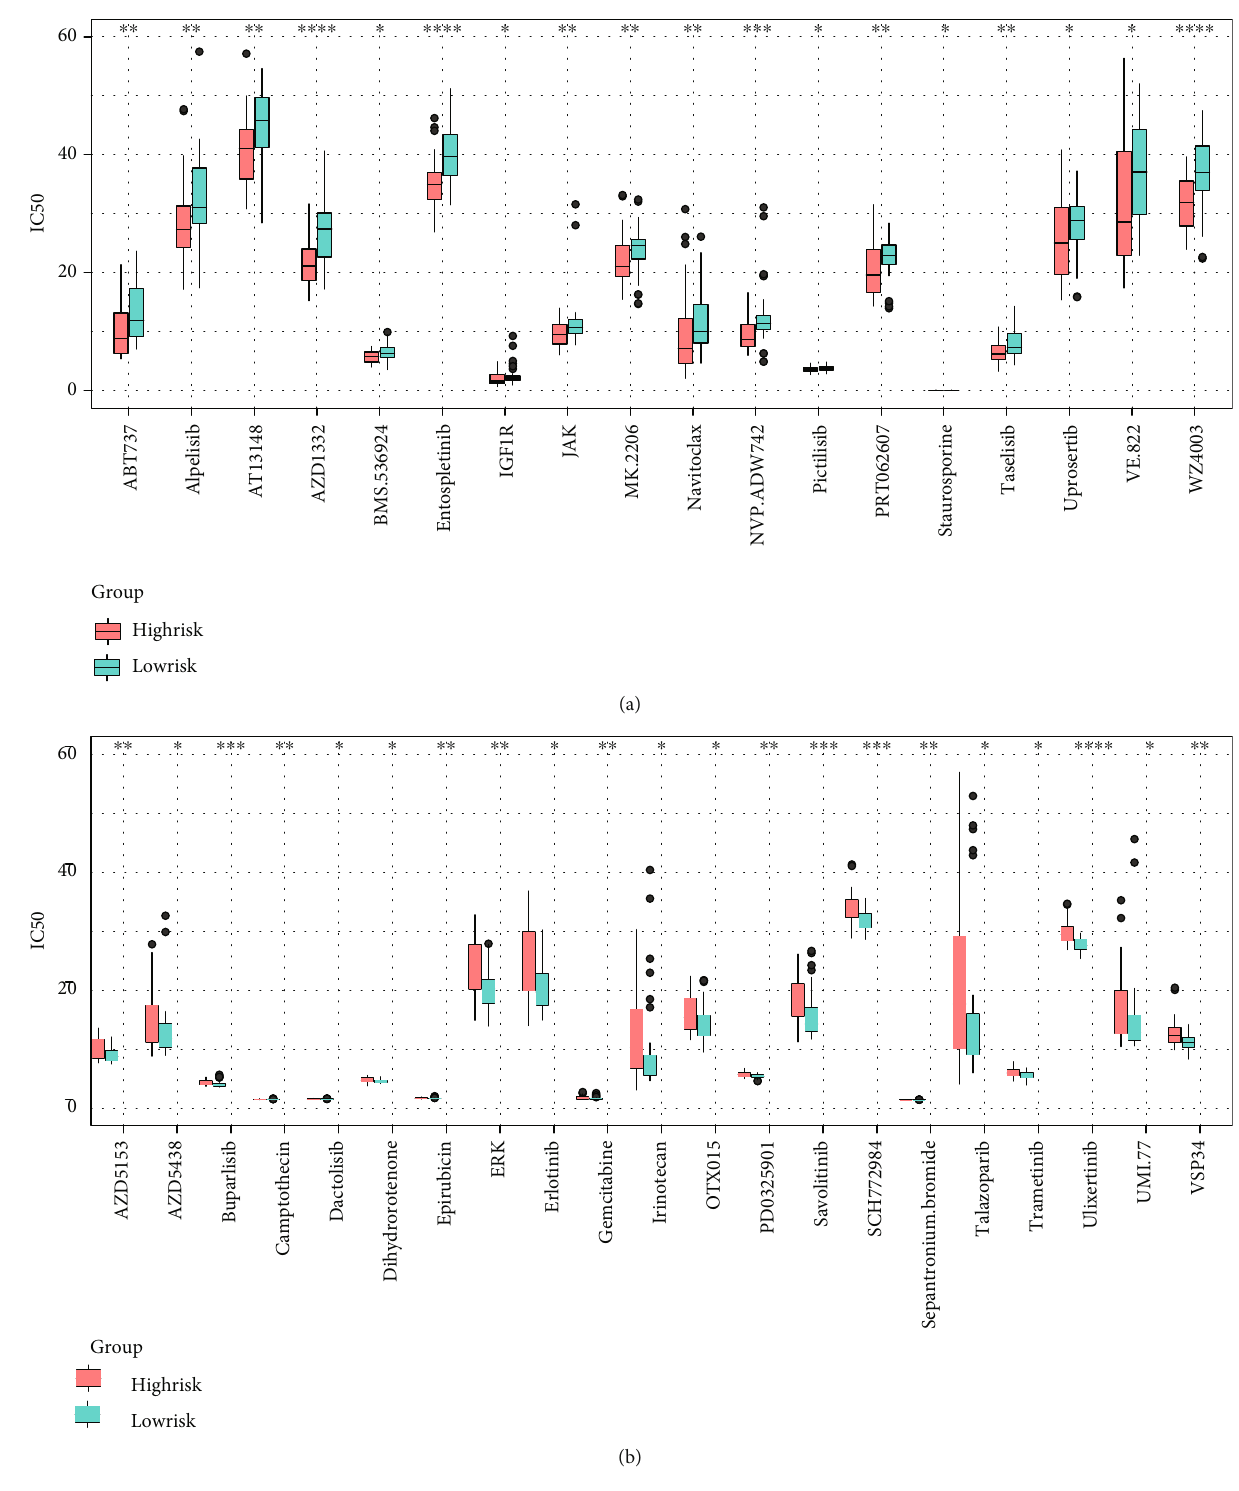
Figure 6: Di ff erences in chemotherapeutic drug sensitivity between high-/low-risk group. (a) Drugs that are more sensitive to high-risk patients. (b) Drugs that are more sensitive to low-risk patients ( ∗ P < 0 : 05 ; ∗∗ P < 0 : 01 ; ∗∗∗ P < 0 : 001 ; ∗∗∗∗ P < 0 : 0001